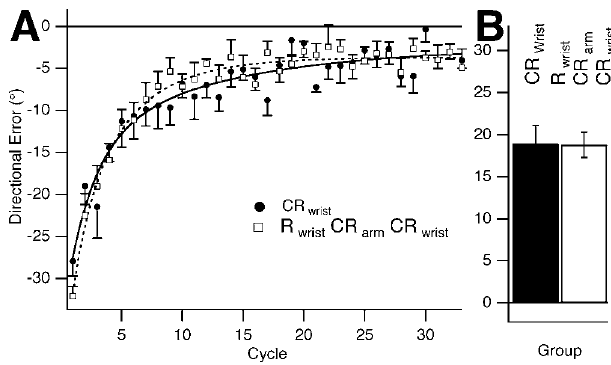
Figure 4. Antecedent Learning of the Rotation with the Wrist Blocks Subsequent Transfer of the Counter-Rotation from Arm to the Wrist (A) CR wrist on day 2, after R wrist followed by CR arm 5 min later on day 1 (group 9, white squares, dashed curve). Also shown is CR wrist on day 1 (group 10, black circles, black curve). There were no savings for CR wrist on day 2 compared to CR wrist on day 1. (B) Bar graph showing no statistically significant difference in the reduction in mean directional error in the first six cycles for CR wrist on day 1 versus day 2 (groups 9 and 10, mean difference ¼(cid:1) 0.14 8 , p ¼ 0.947). DOI: